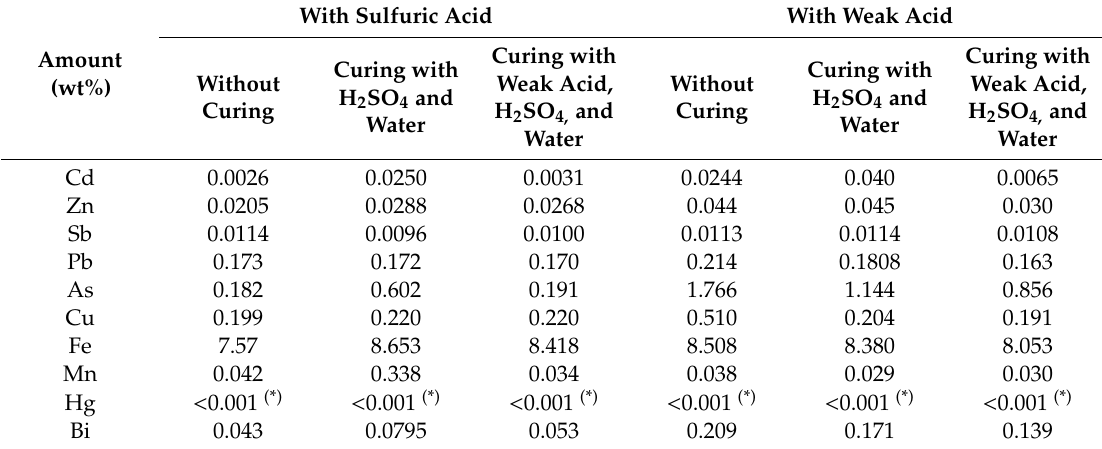
Table 7. Chemical composition of leaching